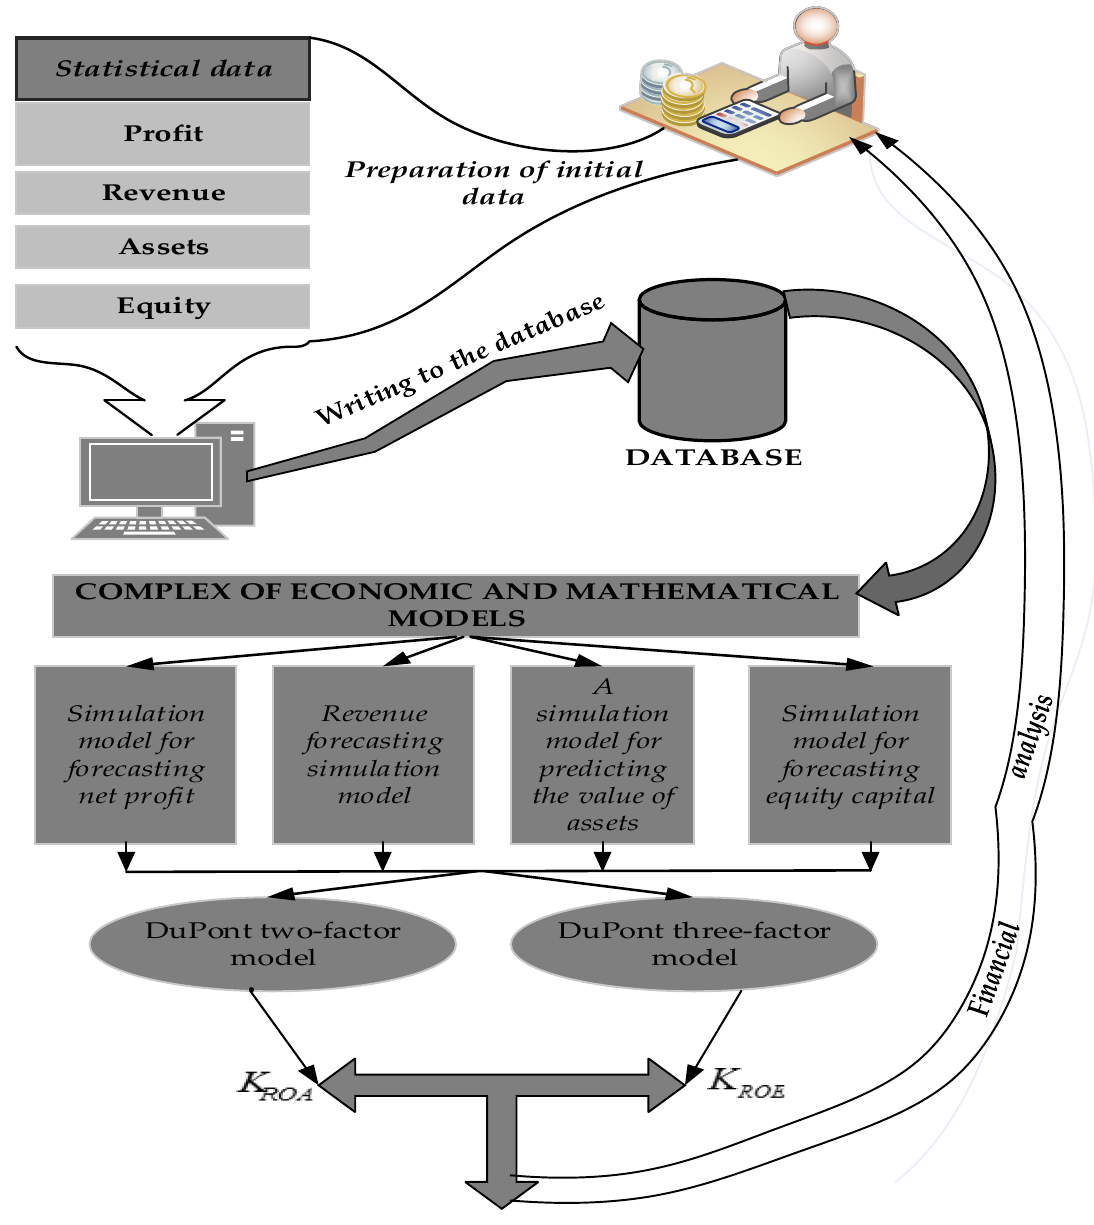
Figure 1. The architecture of the Toolkit the factorial financial analysis.